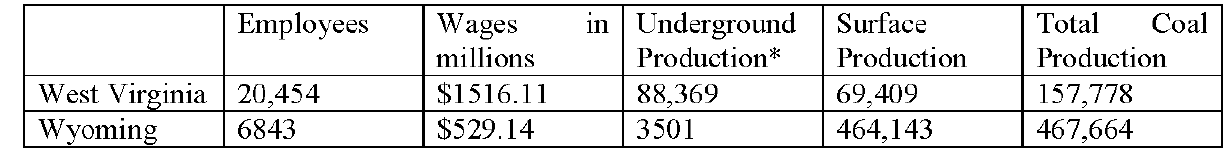
Figure 5. Coal Employment and Production 2008 Employees Wages Ill Underground Surface Total